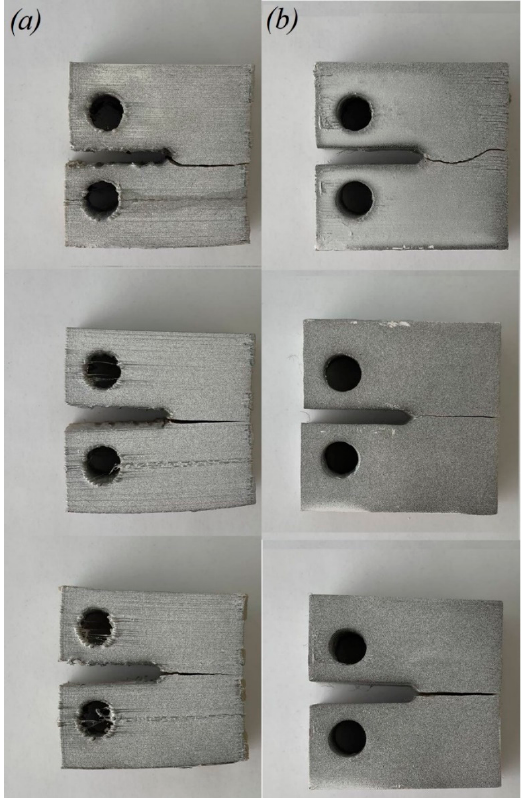
Figure 15. Fractured CT samples printed with vertical ( a ) and horizontal ( b )